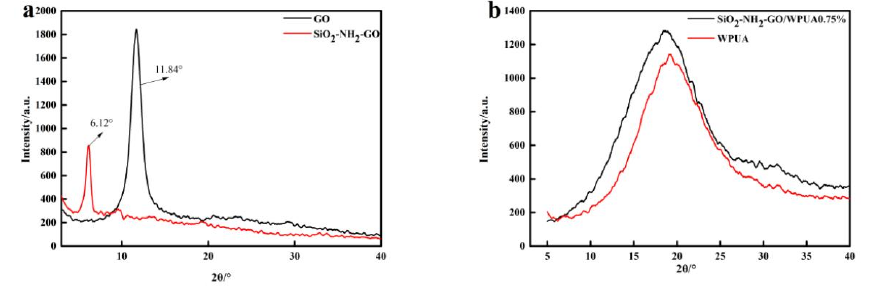
Fig. 6. XRD of GO, SiO 2 -NH 2 -GO, WPUA and SiO 2 -NH 2 -GO/WPUA0.75%